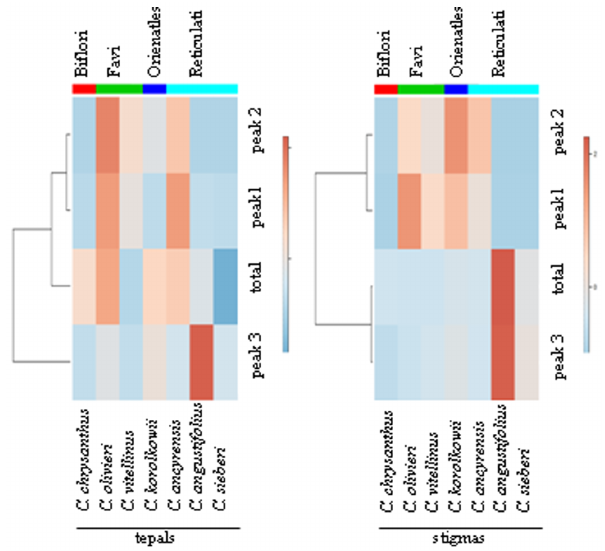
Figure 6. HPLC-PDA chromatograms of aqueous extracts of stigmas in preanthesis and in anthesis of Crocusancyrensis , C. angustifolius , C. chrysanthus , C. korolkowii , C. olivieri and C. vitellinus . For C. sieberi and C. sativus only anthesis chromatograms are shown. Labels correspond to compounds shown in Table 1.